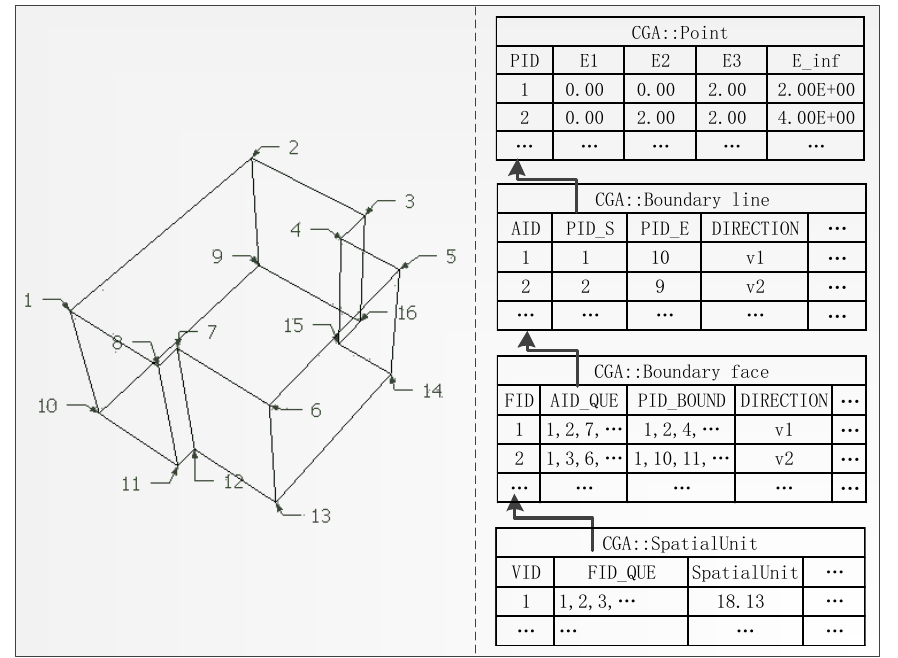
Figure 7. 3D cadastral data organization in a database that is based on CGA